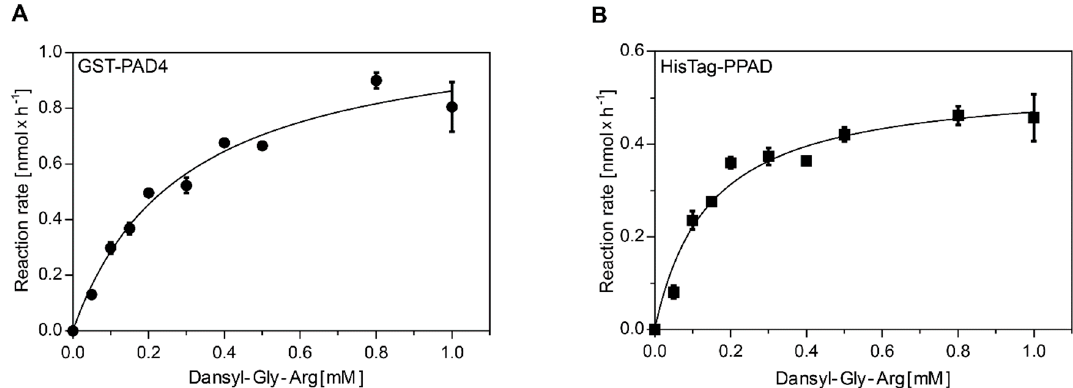
Figure 1. Michaelis–Menten enzyme kinetics for GST-PAD4 ( A ) and HisTag-PPAD ( B ). The rate of enzymatic product formation was plotted against the initial substrate concentration. Reaction rates were determined by incubating GST-PAD4 or PPAD with increasing concentrations of Dansyl-Gly-Arg in the presence of 10 mM CaCl 2 and 10 mM DTT for 60 min prior to product separation by HPLC. Amount of the product formation was calculated based on the product peak integration, compared to the calibration curve. Experimental data (circles, GST-PAD; squares, PPAD), as well as the fitted model (curves) are shown. Results are expressed as mean ± SD, with n = 3.